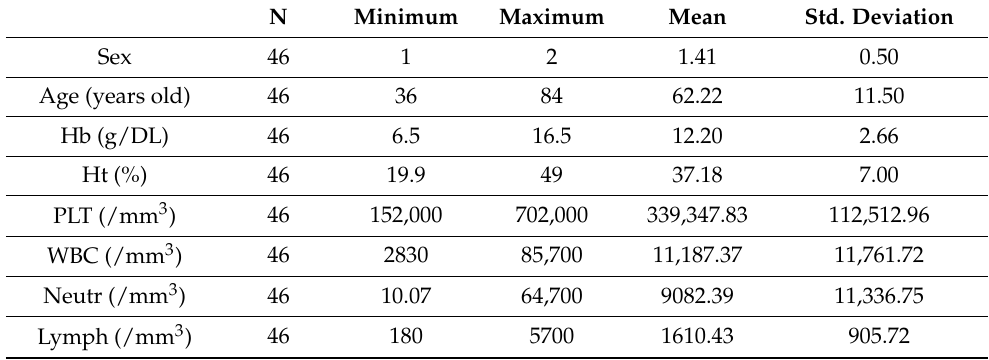
Table 1. Statistics of the parameters considered for carcinomatosis and colorectal cancer study